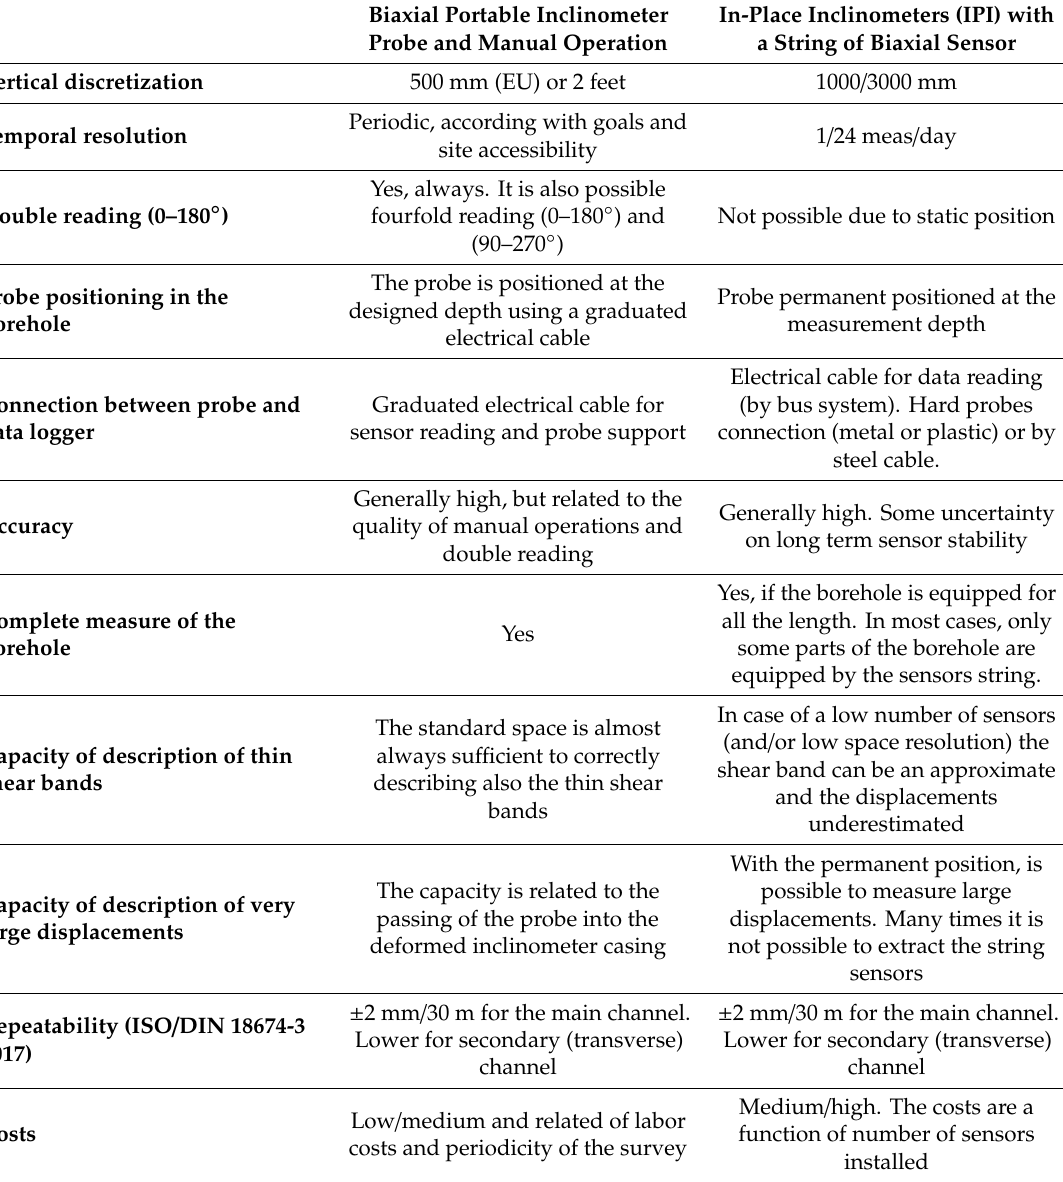
Table 1. Most used inclinometer measurement